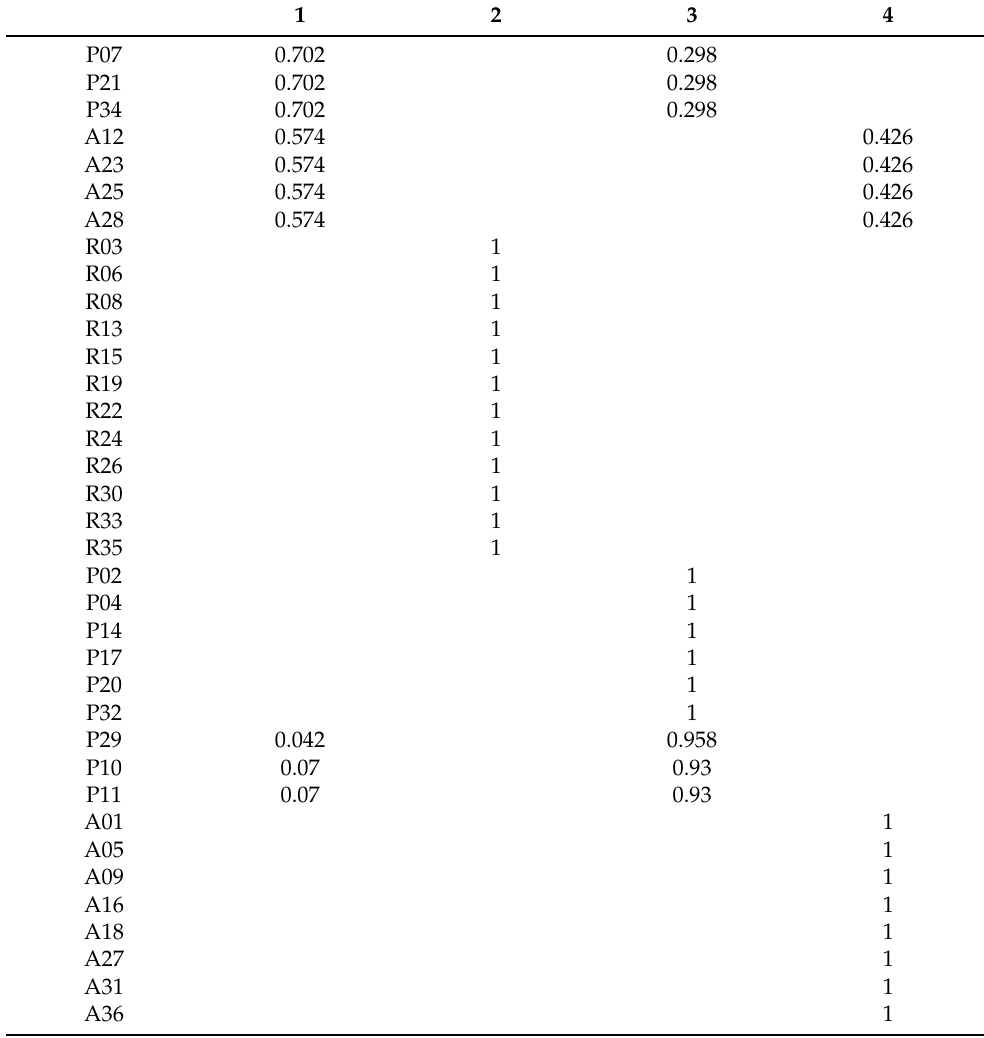
Table 4. Item stability of BAPQ items across all bootstrap replicate